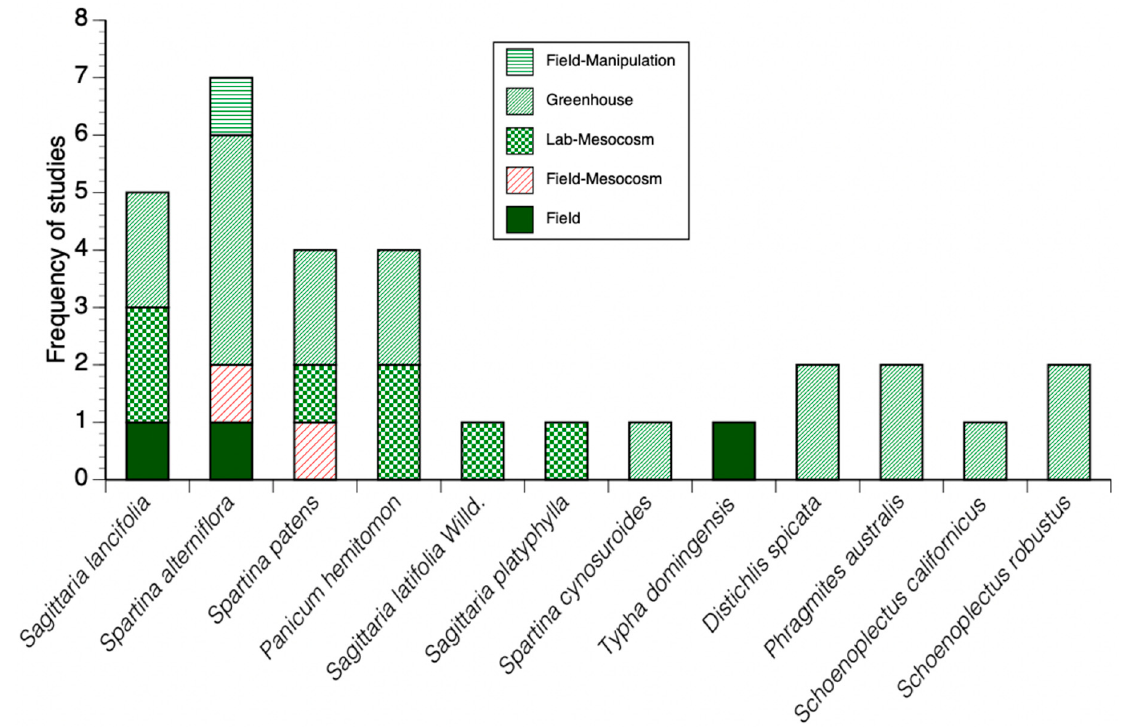
Figure 5. Frequency distribution of ecological studies assessing vegetation belowground biomass under different experimental conditions (greenhouse, laboratory-mesocosm, mesocosm-field, and field settings).